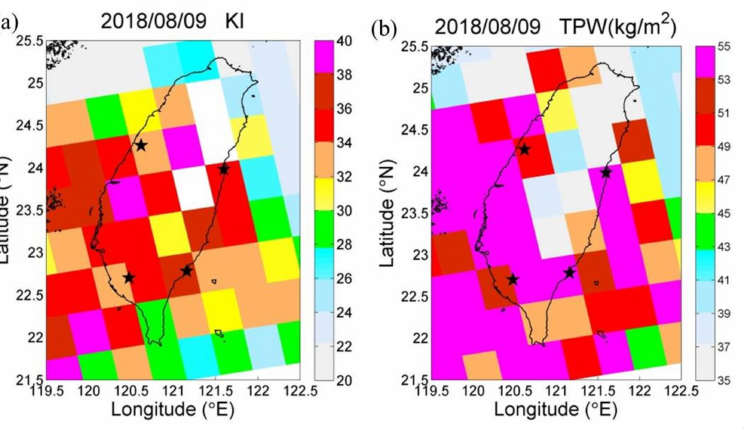
Figure 7. AIRS retrieval on 9 August 2018. ( a ) KI and ( b ) TPW distribution